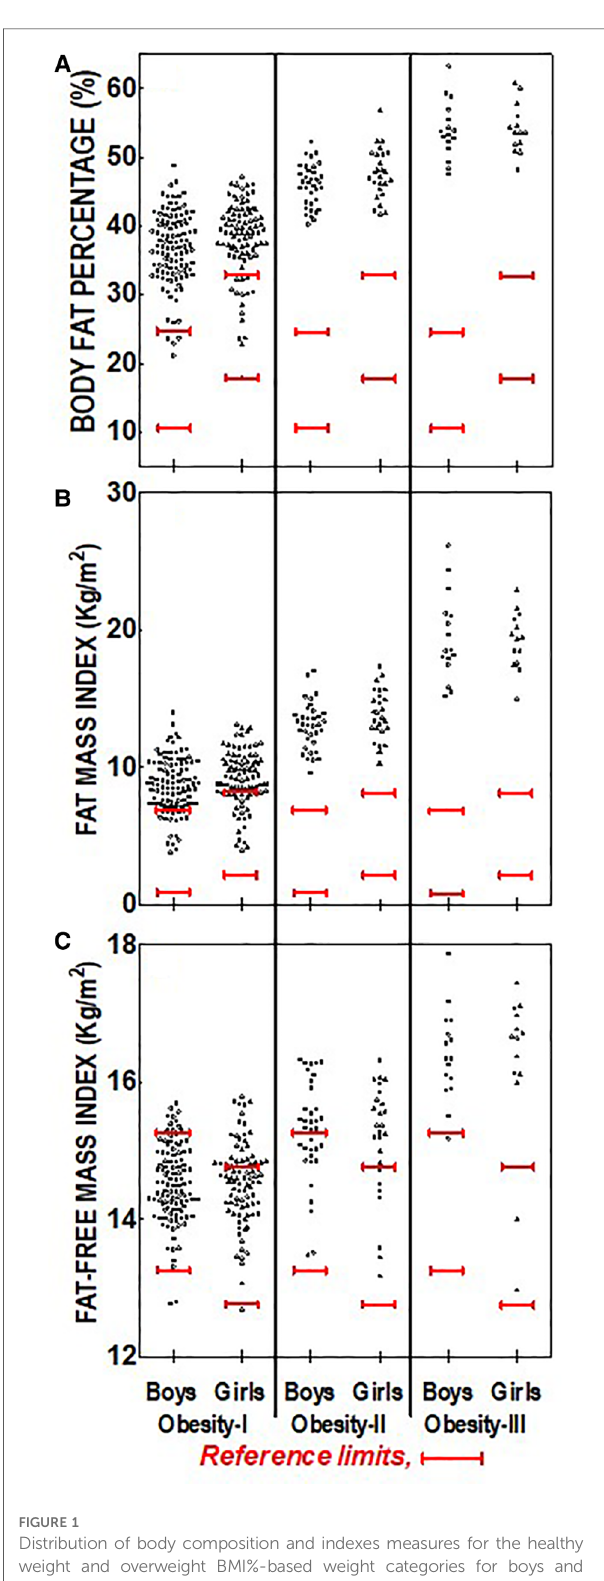
FIGURE 1 Distribution of body composition and indexes measures for the healthy weight and overweight BMI%-based weight categories for boys and girls. ( A ) Solid red lines represent the referenced (27) optimal range body fat percentage for boys (>10% to <24%) and girls (>17% to <32%); ( B ) Solid red lines represent the referenced (28) mean±1SD for the Fat Mass Index for boys (3.5±3 kg/m2) and girls (4.8±3 kg/m 2 ); ( C ) solid red lines represent the referenced (28) mean±1SD for the Fat Free Mass Index for boys (14.2±1 kg/m 2 ) and girls (13.7±1 kg/m 2